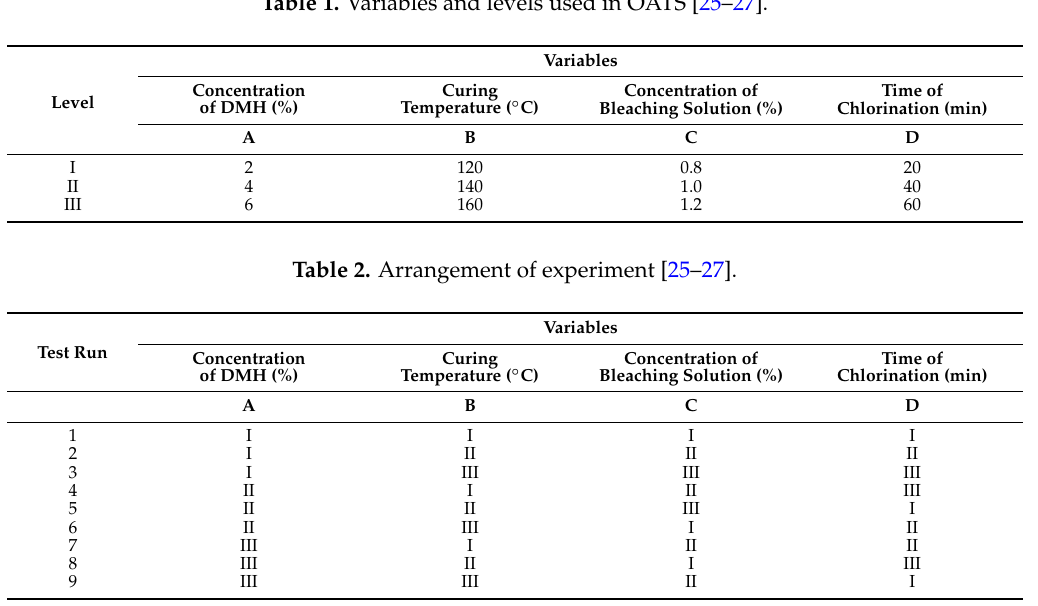
Table 1. Variables and levels used in OATS [25–27].